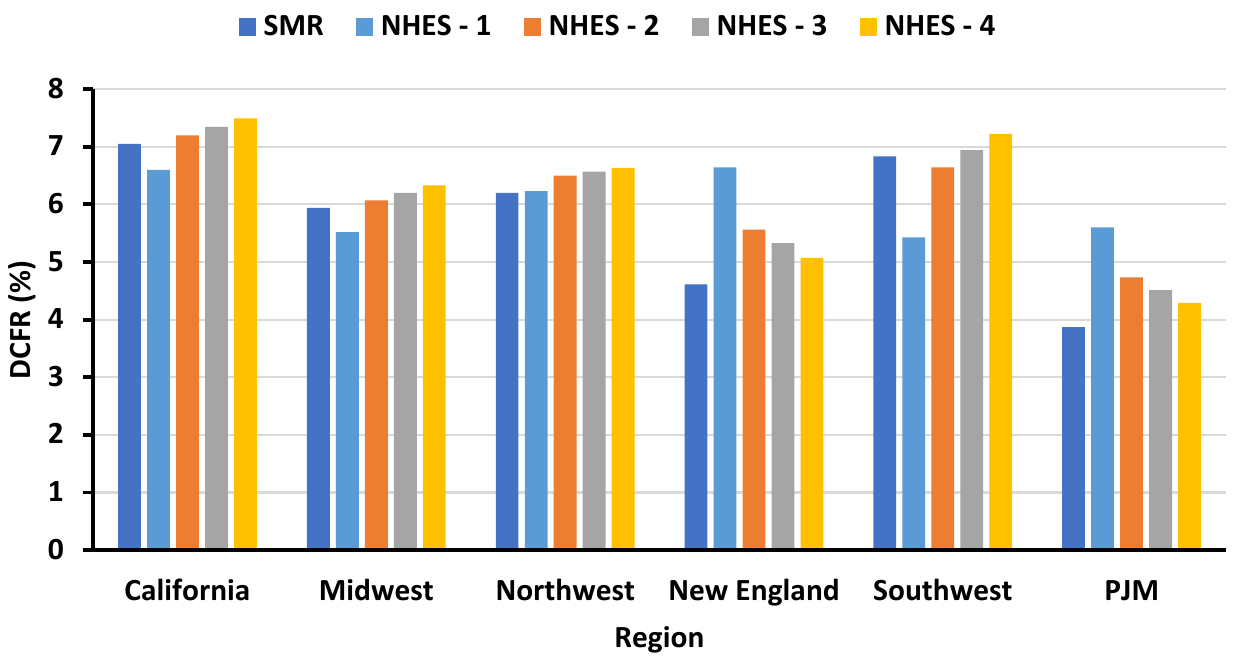
Figure 10. DCFR at different regions for SMR and different SMR-ChHP output scenarios .